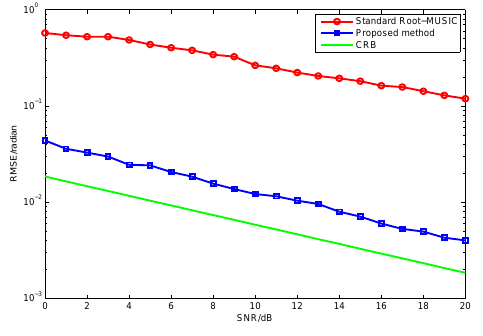
Figure 6. RMSE of η estimates versus SNR with snapshot number 1000.